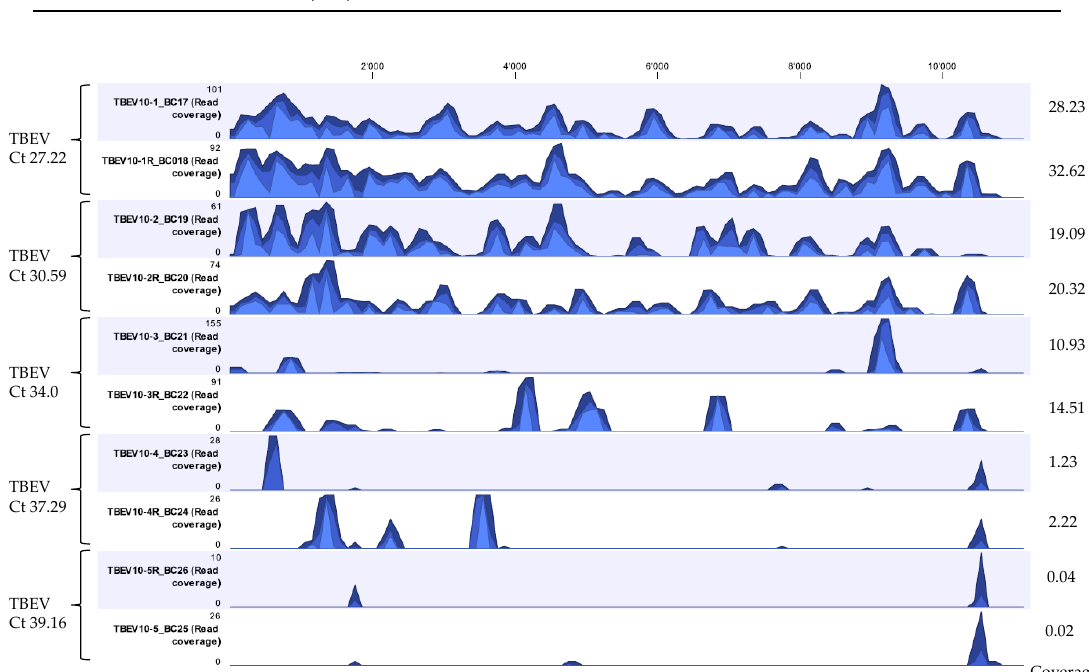
Figure 4. Coverage track profiles of TBEV showing the pattern of sequencing depth obtained for five di ff erent samples sequenced in duplicates with Ct values ranging from 27.22 to 39.16 extracted using the developed Method 5. Ion S5 reads from each sample were mapped on to the TBEV reference genome NC-001672.1. Average coverage values are indicated for each sample on the right. In the graph track, the three blue shades show the minimum (light blue), mean (medium blue), and maximum (dark blue) observed values in a given